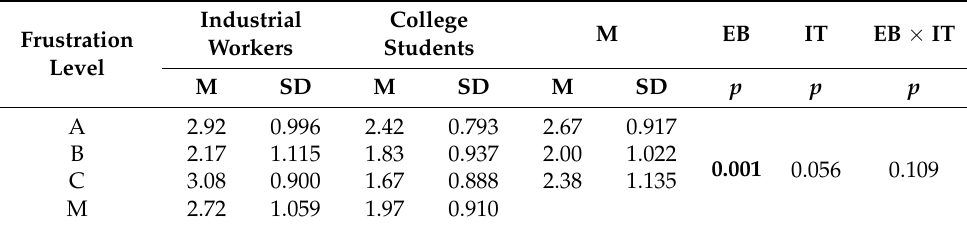
Table 10. Descriptive statistics and two-way ANOVA on frustration by NASA-TLX.